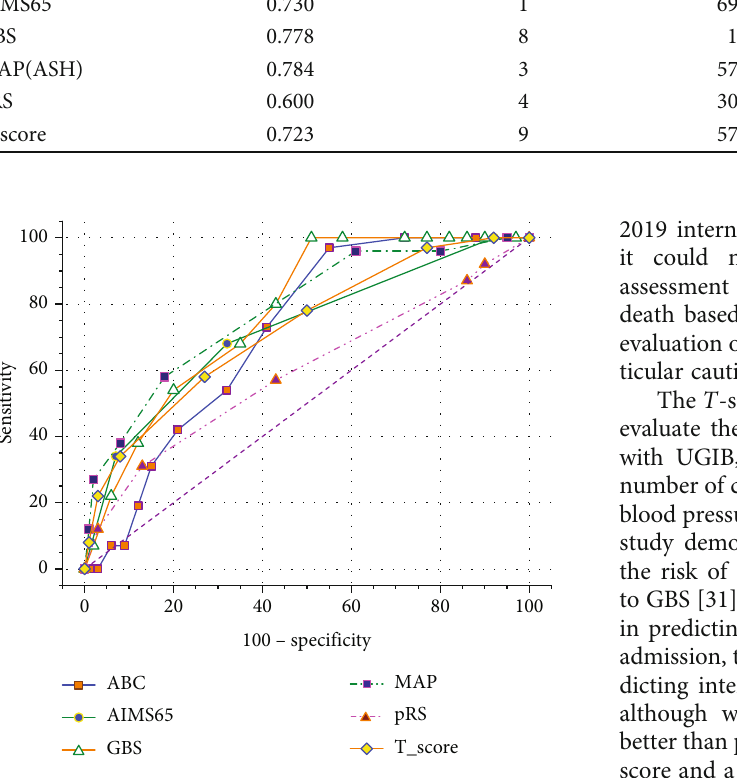
Figure 4: ROC curves for six scoring systems in evaluation of ICU admission.